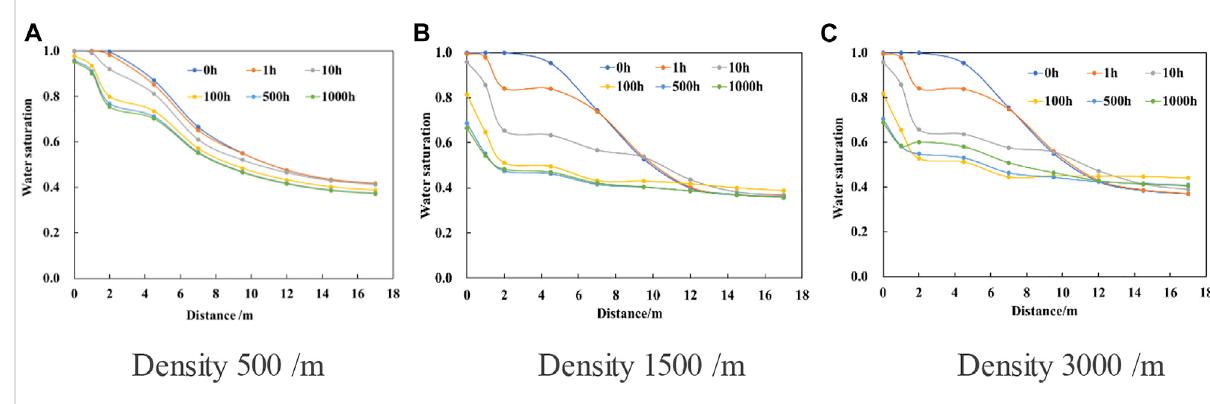
FIGURE 19 Water saturation of the main fracture at different transverse distances in different lamellation-fracture densities. The pressure changes of fracture systems with different splicing densities after 10 days of shut-in are shown as follows: (A) Density 500 m; (B) Density 1,500 m; and (C) Density 3,000